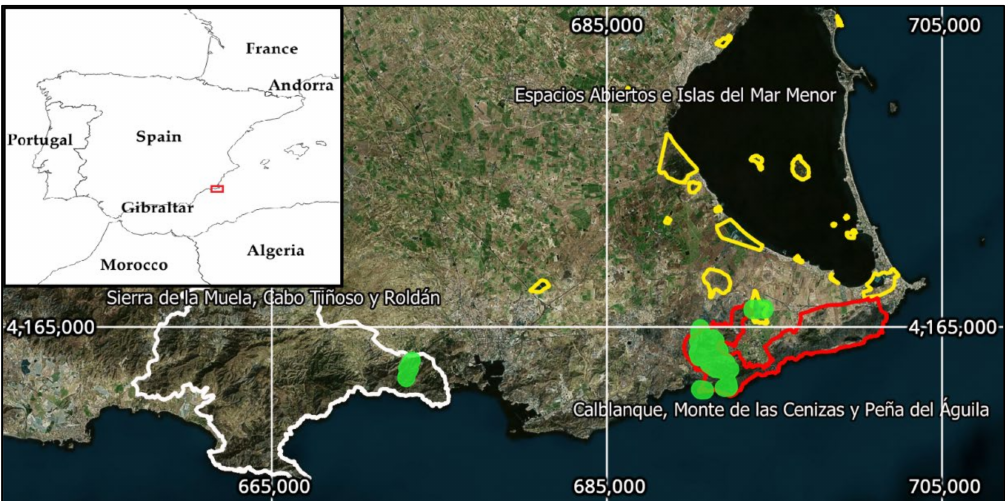
Figure 1. Study area location in the southeast of the Iberian Peninsula (Region of Murcia, Spain). Colored lines represent Protected Areas limits. The LIFE project actions were performed in the green areas (EPSG Projection 25830-ETRS89/UTM zone